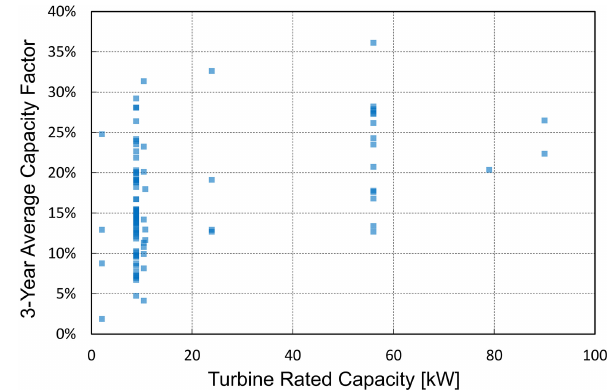
Figure 8. Measured LCOE for SWT projects in the US data from Orrell et al.